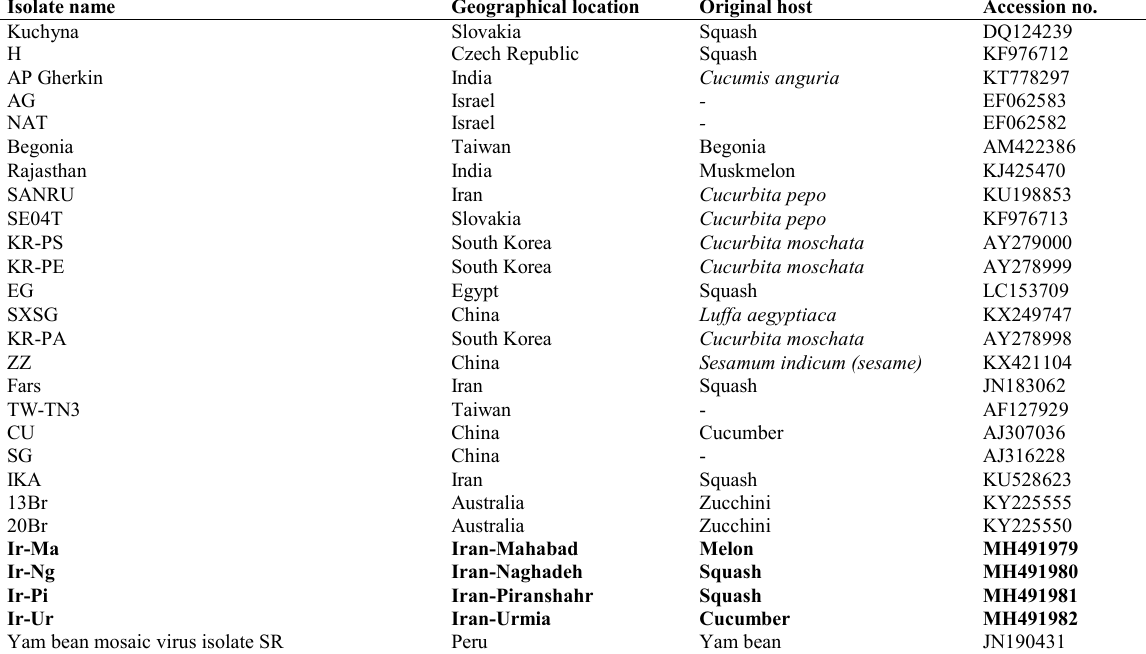
Table 3 . Name and origin of ZYMV isolates included in the phylogenetic analysis and accession numbers of the newly- generated sequences. The new Iranian isolates of this research are bolded.